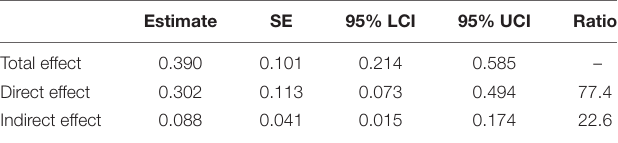
TABLE 5 | Estimate of standardized effect sizes.